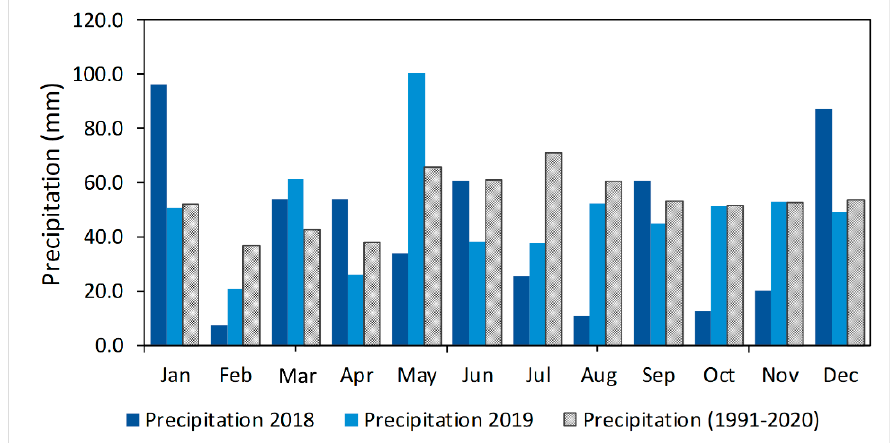
Figure 3. Monthly precipitation sums in the Antrift catchment during the investigation period, compared to long-term average monthly precipitation (reference period 1991–2020). (Data source: HLNUG (2019); operator: Deutscher Wetterdienst, data for the climate station Alsfeld-Eifa, station-ID: DWD91, 50.7447° N, 9.345° E.).